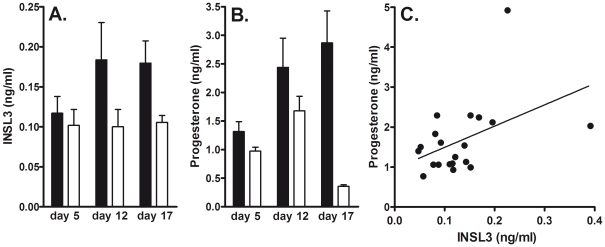
Circulating INSL3 (A) and progesterone (B) concentrations in gravid (filled bars; N = 6) and non-gravid (open bars; N = 4) sheep (means ± SD).Statistical significance is shown only where P<0.05. (C) Correlation (r = 0.4; P<0.05) of INSL3 and progesterone values for samples collected on days 5 and 12 only, excluding day 17 (luteolysis).